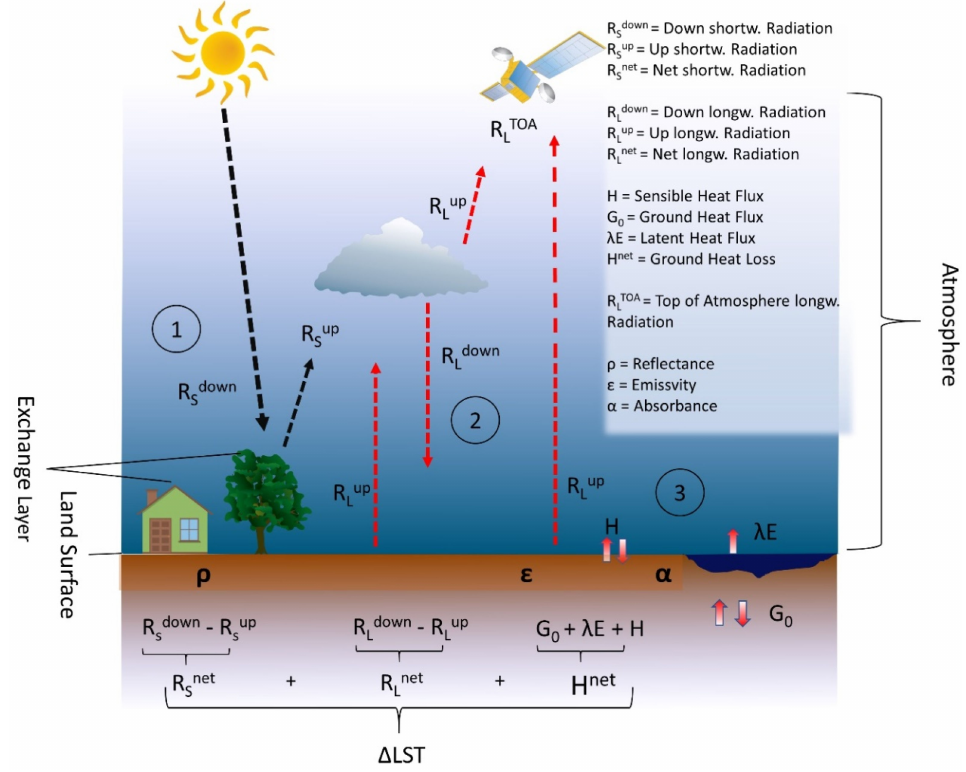
Figure 2. Schematic overview illustrating the components constituting LST in the surface energy budget: the shortwave radiation balance (1), the longwave energy balance (2) and the ground heat loss